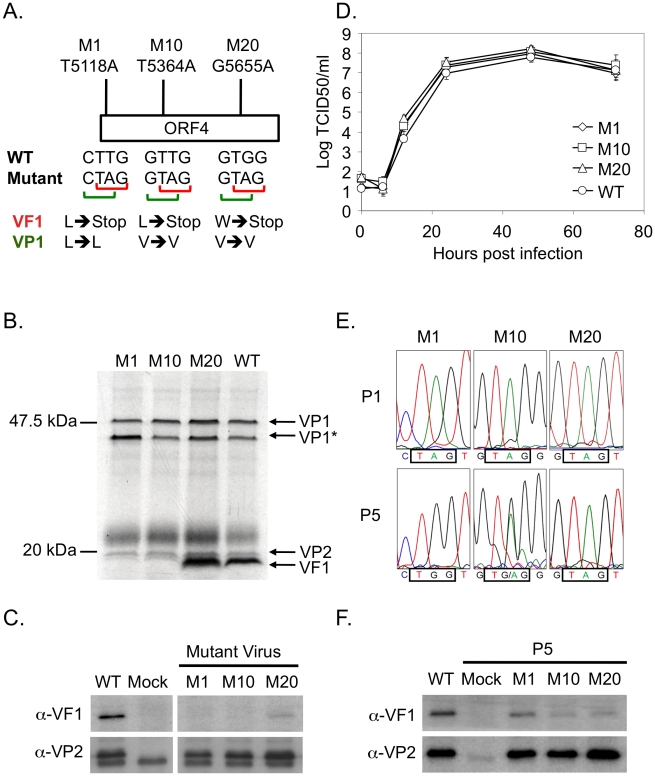
VF1 is not required for murine norovirus replication in tissue culture although there is a ‘fitness cost’ to the virus.(A) Schematic representation of the position and nucleotide changes introduced to generate the VF1 mutant viruses M1, M10 and M20. Nucleotide numbers refer to the positions in the MNV-1 genome. The effect of the introduced nucleotide changes on the VF1 and VP1 protein sequences are also illustrated. Note that the mutations introduced in M1, M10 and M20 do not affect the coding sequence of the capsid protein VP1 but introduce a stop codon into VF1 at various positions. (B) Coupled in vitro transcription and translation reactions confirming the lack of VF1 expression in M1 and M10 viruses, with M20 producing a marginally shorter VF1 product. PCR products containing the subgenomic RNA region under control of a T7 RNA polymerase promoter were generated from cDNA constructs of either wild-type (WT), M1, M10 or M20 VF1 mutants and subsequently used for transcription and translation (TNT) in vitro in the presence of S35 methionine. Radioactively labeled proteins were subsequent resolved by SDS-PAGE, prior to exposure to film. VP1* represents a potential shorter VP1 product generated by translation initiation from an AUG initiation codon in-frame yet downstream from the authentic VP1 AUG. (C) Western blot analysis of RAW264.7 cells infected with low passage, sequence verified stocks of either wild-type (WT), M1, M10 or M20 VF1 mutant viruses. RAW264.7 cells were infected at a MOI 10 TCID50 per cell and harvested 12 hours post infection, prior to separation by SDS-PAGE and western blot using either anti-VF1 or anti-VP2 antisera. (D) Multi-cycle growth kinetics analysis of VF1 mutant viruses M1, M10 and M20 in RAW264.7 cells. Cells were infected with a MOI of 0.01 TCID50 per cell and samples harvested at various times post infection prior to titration on RAW264.7 cells. Virus yield is expressed as TCID50/ml. Infections were performed in triplicate, with the average virus titer and standard deviation plotted. (E) Sequence chromatograms of M1, M10 and M20 VF1 mutant viruses after passage 1 or 5 in RAW264.7 cells. Viruses obtained from passage 1 and 5 low multiplicity infections (MOI) of RAW264.7 cells were used to infect a subsequent monolayer at high MOI prior to RNA isolation, RT-PCR amplification of the region encompassing ORF4 and sequence analysis. The positions of the introduced stop codons in the mutants M1, M10 and M20 are boxed as are the sequences after 5 repeated passages in cell culture. (F) Western blot analysis of VF1 and VP2 expression in cells infected with either wild-type MNV or passage 5 VF1 mutant viruses M1, M10 and M20. 18 hours post infection at a high MOI (4 TCID50 per cell) cells were harvested, separated by SDS-PAGE prior to western blot analysis using antisera to either VF1 or VP2. Note that batch-to-batch variation in the quality of the anti-VP2 antisera accounts for the variations in the levels of non-specific proteins detected in panels C and F.